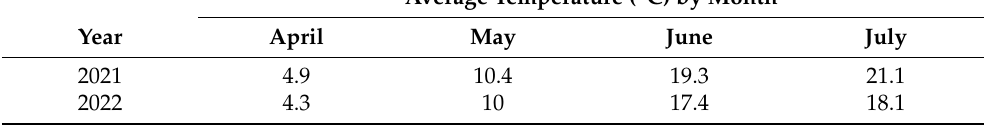
Figure 1. Average daily temperatures (°C) and rainfall (mm) during April, May, June and July in testing years (2021–2022) in Polli. Table 1. Average monthly temperatures (°C) during April, May, June and July in test years (2021– 2022) in Polli.